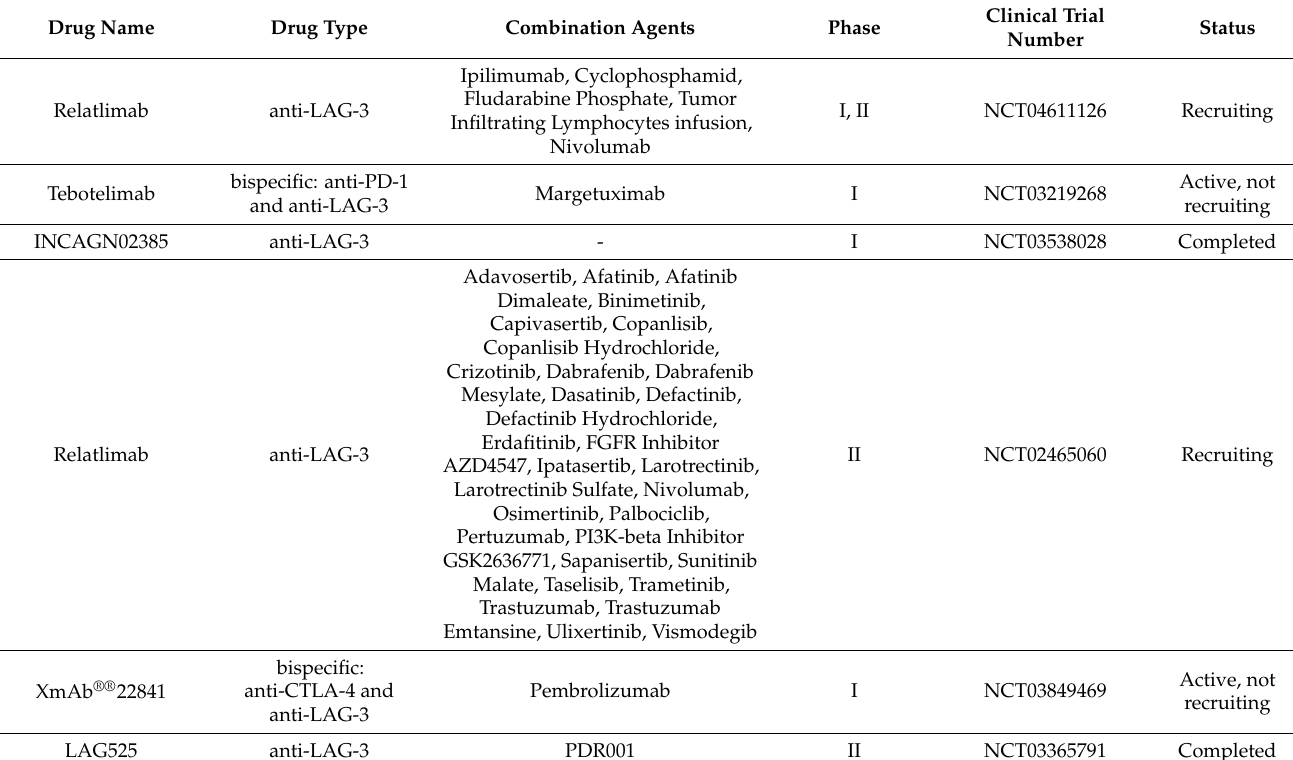
Table 4. Clinical trials showing treatment of ovarian cancer with anti-LAG-3 antibodies (https: //clinicaltrials.gov/, accessed on 27 September